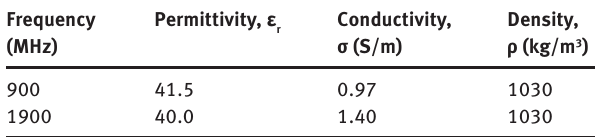
Table 2 Homogeneous human head dielectric